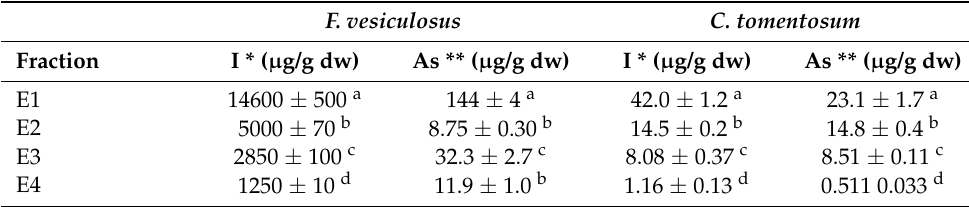
Table 3. Iodine and arsenic content of SWE extracts (mean ± SD).